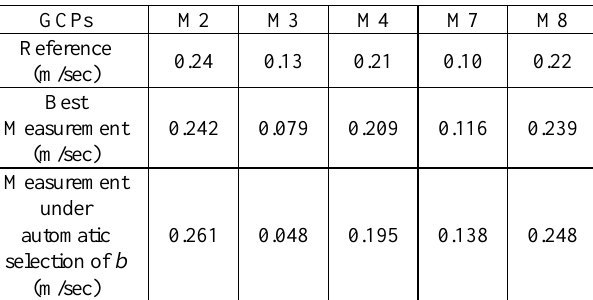
Table 1. Statistical Analysis of Measurement